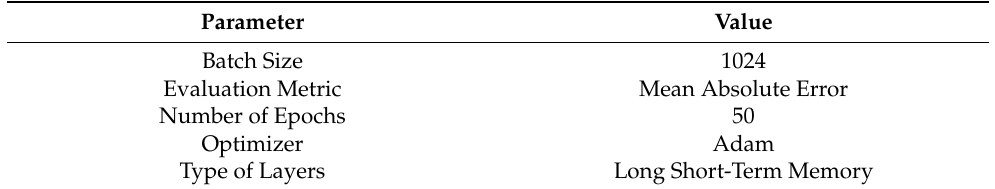
Table 1. Hyperparameter Optimization—Fixed Parameters. Parameter Value Batch Size 1024 Evaluation Metric Mean Absolute Error Number of Epochs 50 Optimizer Adam Type of Layers Long Short-Term Memory